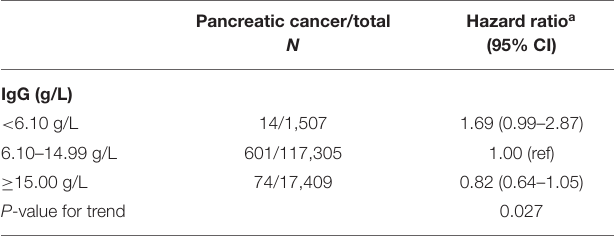
TABLE 2 | Hazard ratio (HR) for risk of pancreatic cancer, in the study population with a measurement of IgG, with 95% confidence intervals (CI) using Cox proportional hazards model.